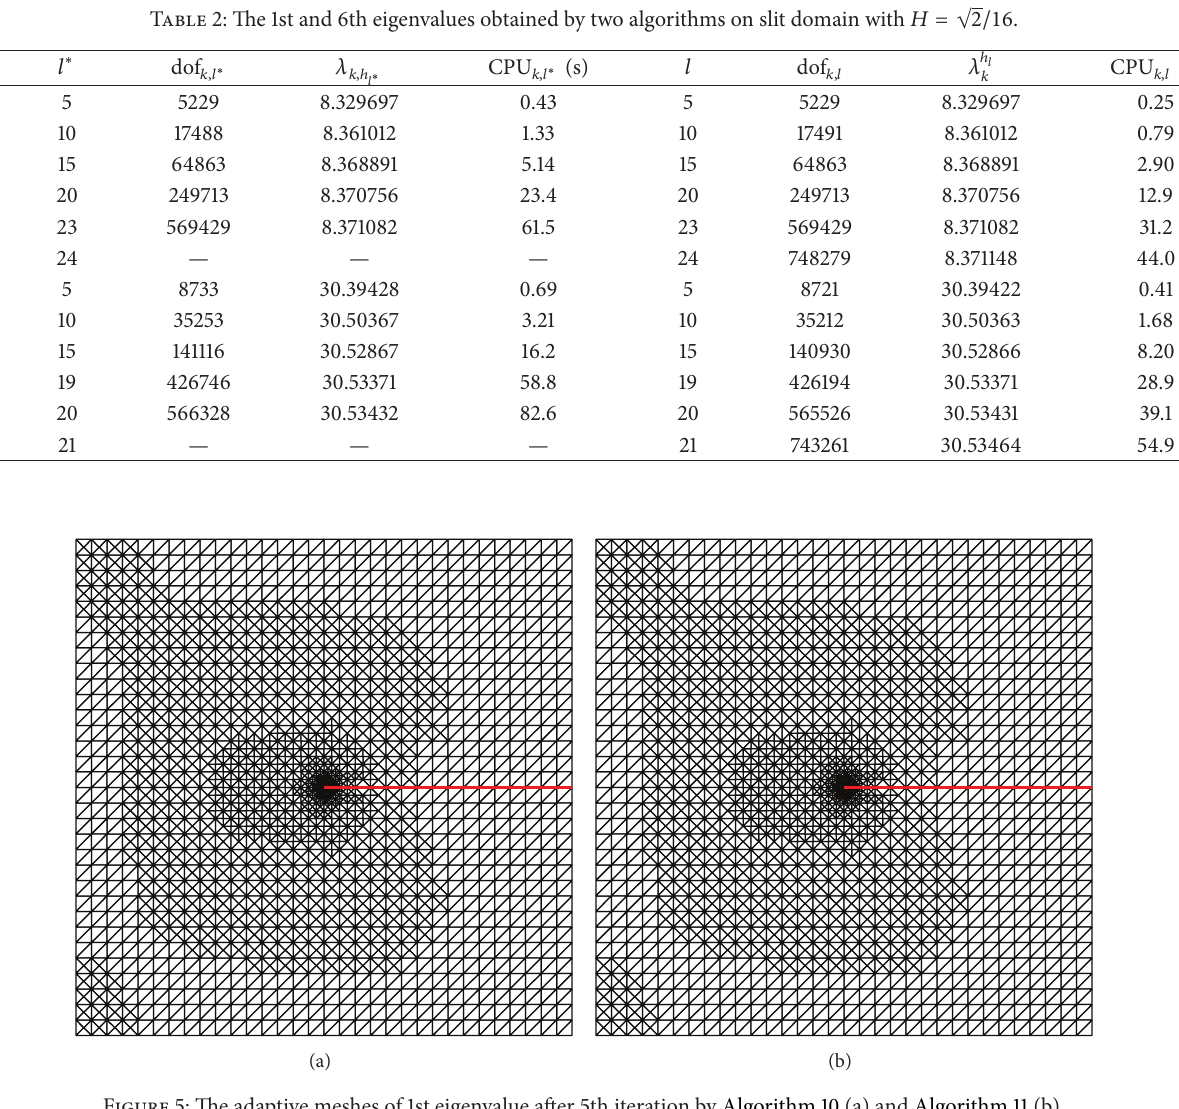
Figure 5: The adaptive meshes of 1st eigenvalue after 5th iteration by Algorithm 10 (a) and Algorithm 11